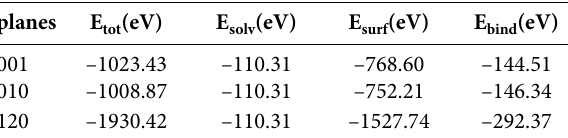
Table 3. After adding PVP, PVP monomer and easy to show surface adsorption related energy parameter table